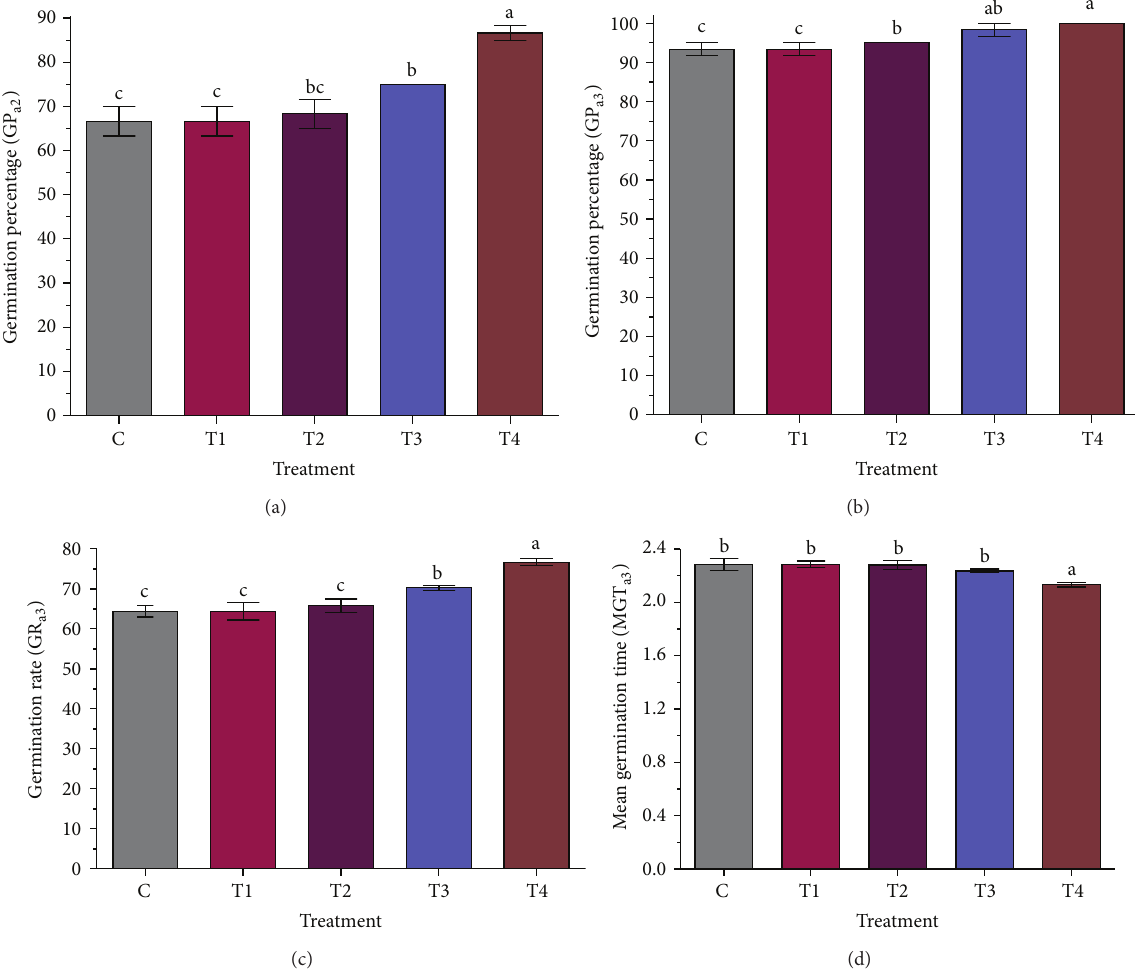
Figure 1: Seed germination of MR 219 rice variety under different times of microwave frequency treatments. (a) Germination percentage after two days of treatment, (b) germination percentage after three days of treatment, (c) germination rate after three days, and (d) mean germination time after three days. Mean values ± SE are from three independent replicates, and values superscripted by different letters are significantly different by Duncan’s multiple range test ( 𝑃 ≤ 0.01 ). The treatments were (C) control, (T1) One hour, (T2) four hours, (T3) seven hours, and (T4) ten hours of exposure times of microwave frequency.